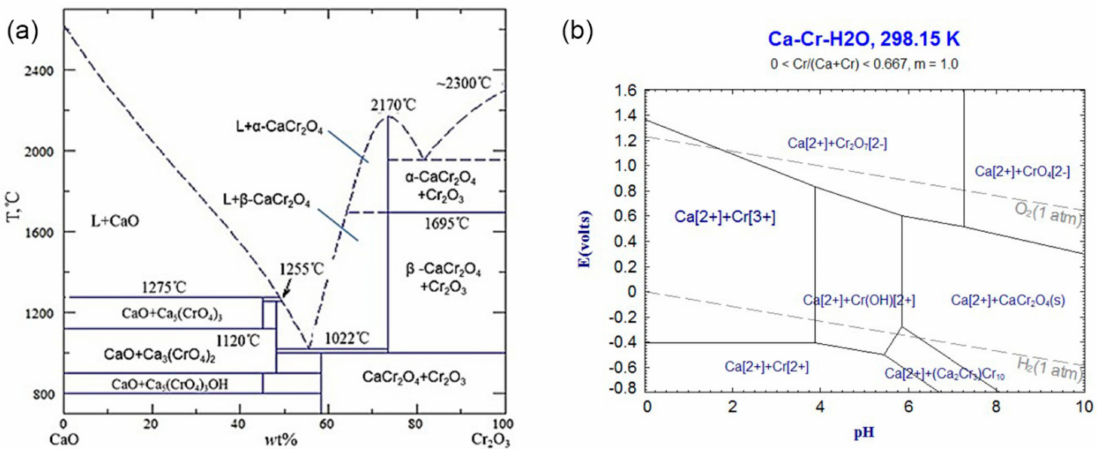
Figure 8. ( a ) Binary phase diagram of CaO–Cr 2 O 3 and ( b ) Eh–pH diagram of Ca–Cr–H 2 O systems at 25 ◦